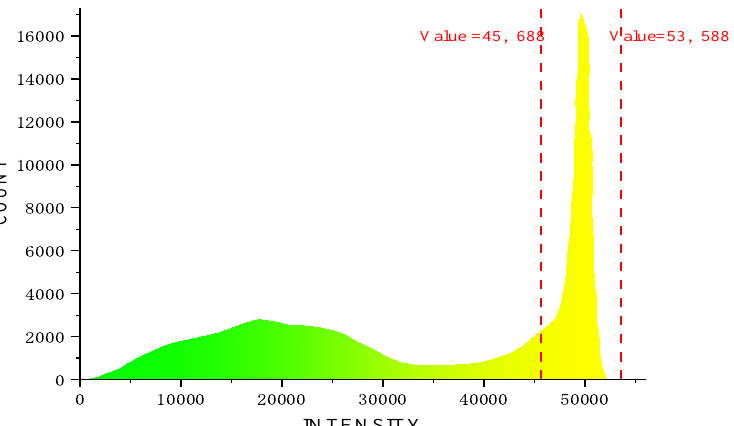
Figure 12. Selecting a range of intensity values of the laser point clouds of Figure 11 for segmentation.